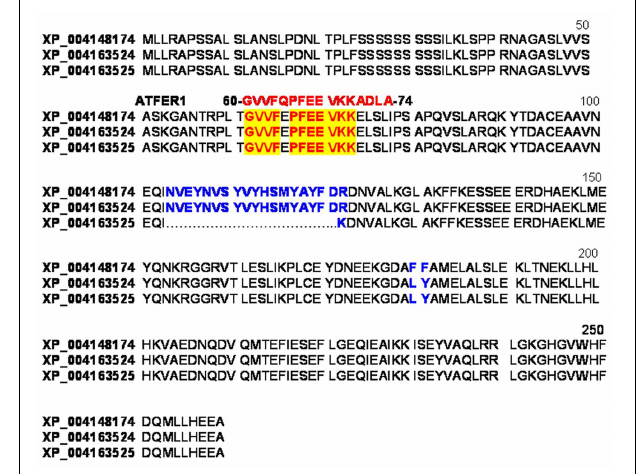
FIGURE 3 | Sequence alignment of the three predicted cucumber ferritin protein variants of the unique ferritin gene: XP_004148174, XP_004163524identical to Csa5M215130 and XP_004163525. In blue are the aa residues differing among the three sequences; highlighted in red are the aa identical to those in the 16-aa peptide GVVFQPFEEVKKADL used as antigen for raising the anti-ATFER1